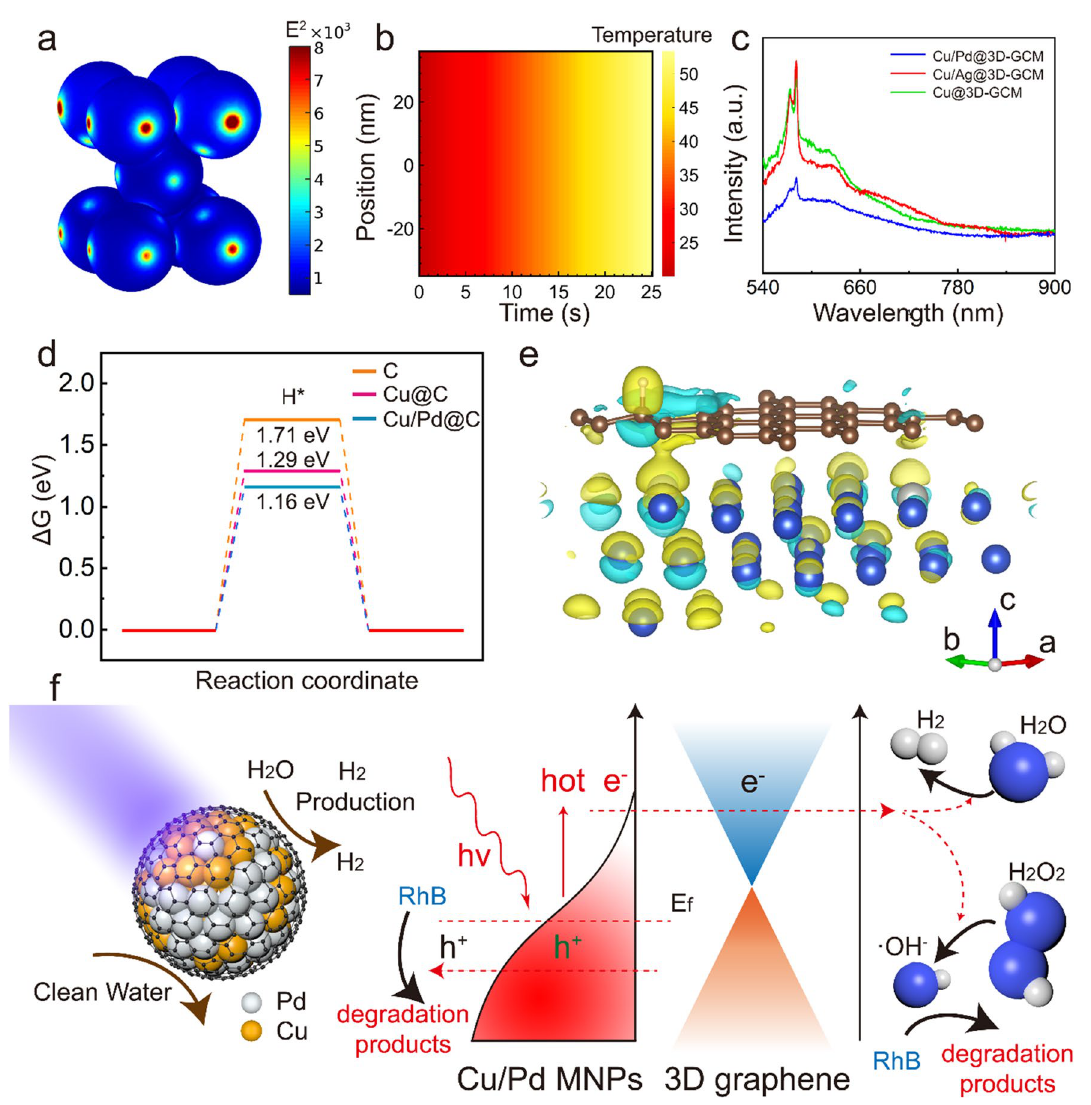
Fig. 4 a, b Simulated electric field distributions and temperature variation of the sample under light irradiation of 350 nm by three‑dimensional finite element analysis. c PL spectra of 3D‑GCM. d The calculated free‑energy diagram of the HER on C, Cu@C, and Cu/Pd@C; e the charge density redistributions of a 3D‑GCM system (The blue, brown, and white atoms represent Cu, C, and Pd, respectively). Blue represents the loss of charge, and yellow represents the gain of electrons in charge density isosurface plot. f A schematic diagram of hot‑electron generation. The graphene layer is used as a high‑efficiency electron acceptor to degrade pollutants and release